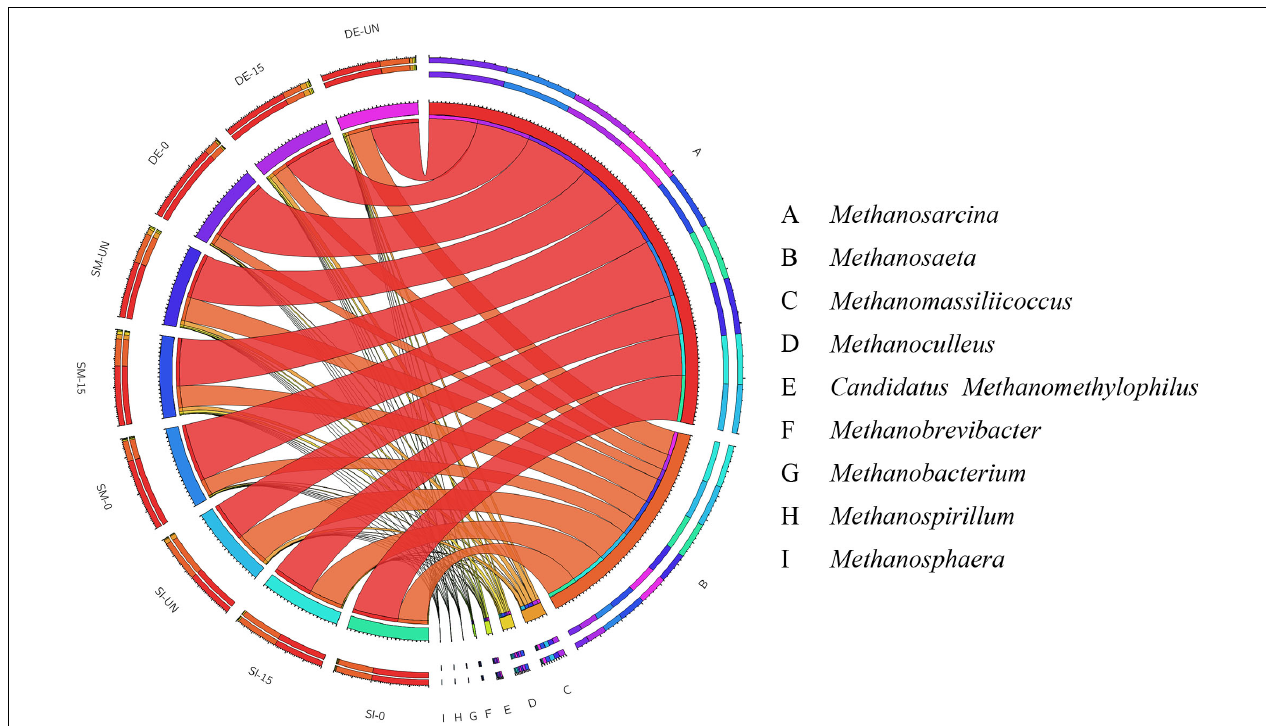
FIGURE 7 | The relative abundance of archaea in the selected digestates after AD at the genus